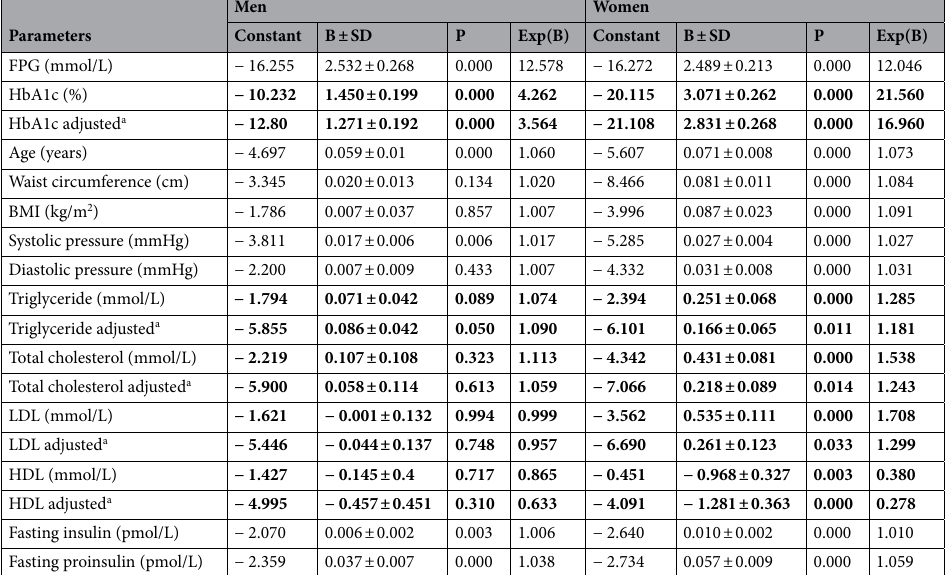
Table 1. Binary logistic regression analysis of anthropometric and biochemical parameters for T2D. a Adjusted for age, smoking, overweight, hyperlipidemia, hyperuricemia and diabetes. Items in bold indicate significantly different odd ratios Exp(B) between men and women.